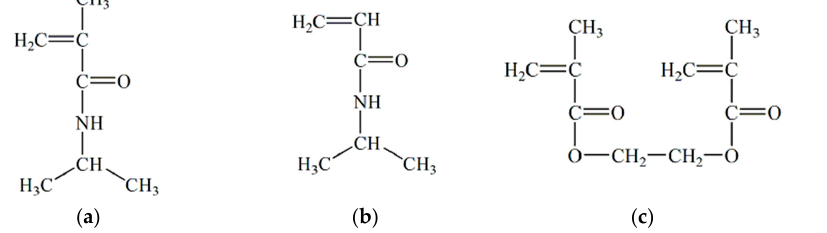
Figure 1. Chemical structure of curcumin.